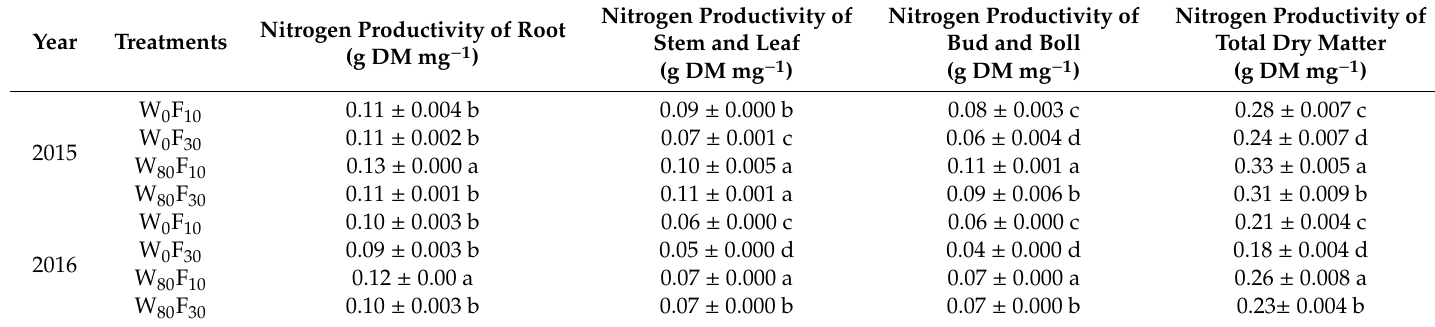
Table 4. Changes in root nitrogen, stem plus leaf, nitrogen bud plus boll and total dry matter nitrogen productivity under di ff erent irrigation and fertilization during2015 and